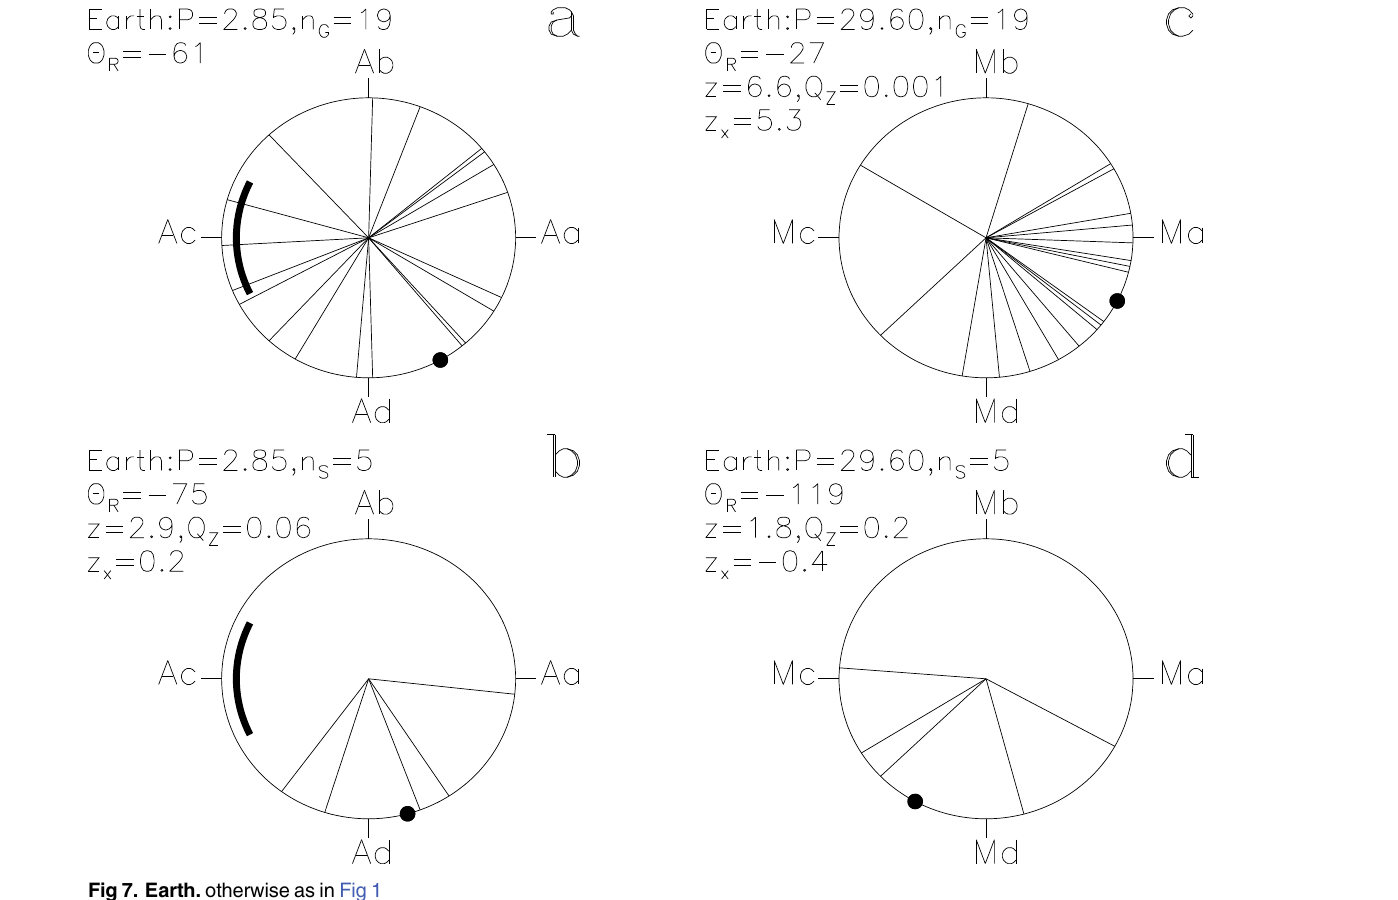
Fig 7. Earth. otherwise as in Fig